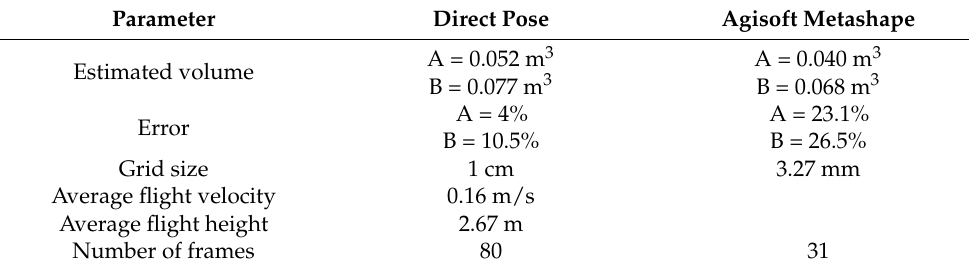
Table 1 . Indoor experiment, quantitative data. Table 1. Indoor experiment, quantitative data.